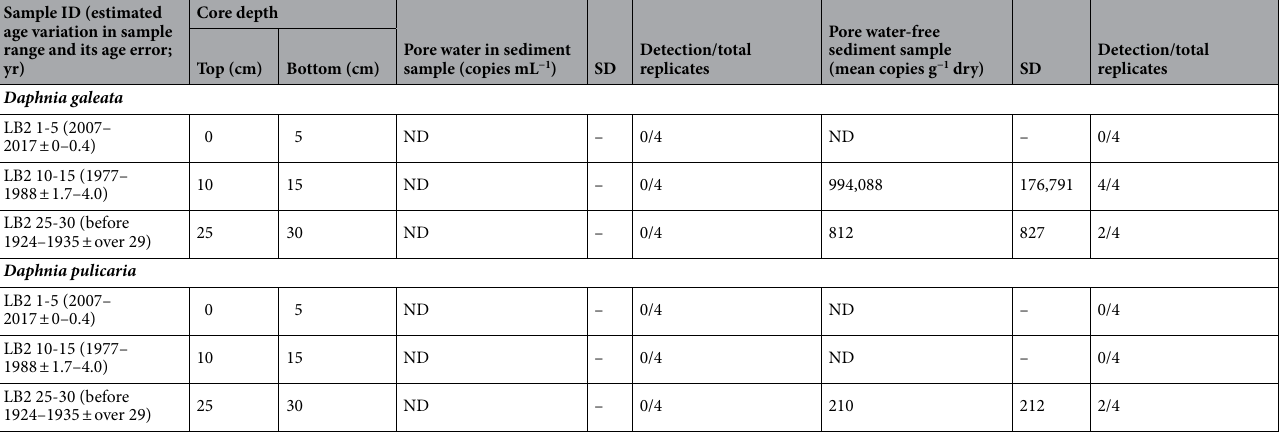
Table 1. 12S rRNA gene copy numbers (copies g −1 of dry sediment) for each species for pore water in sediment and its residual pore water-free sediment